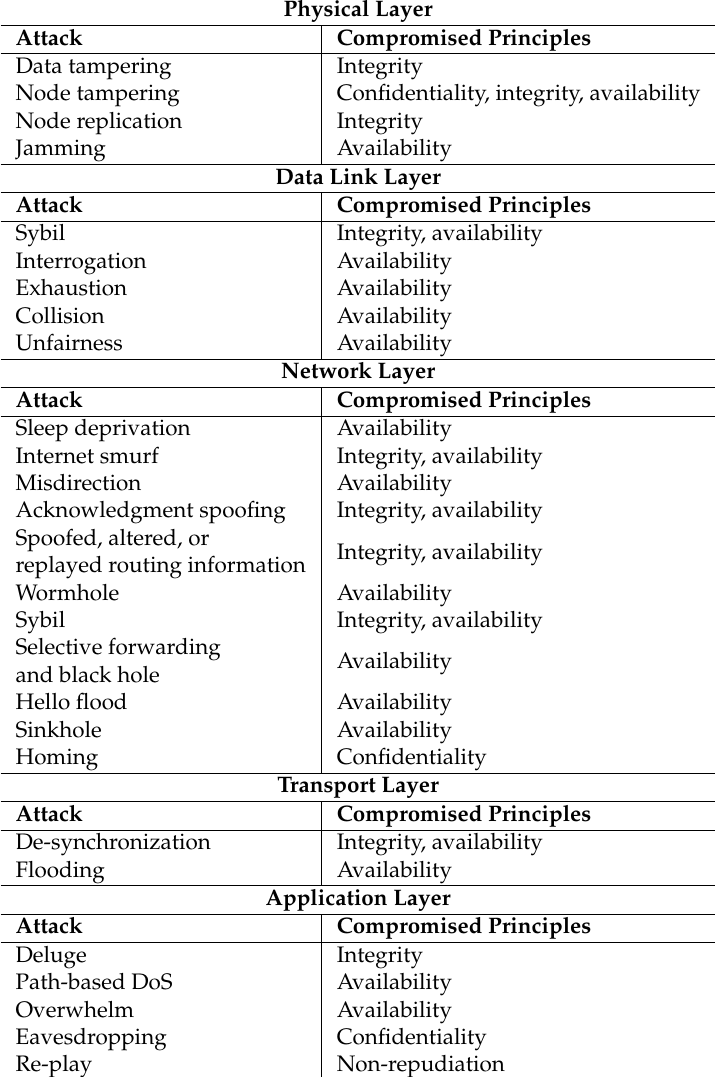
Table 1. Information security principles compromised by WSN